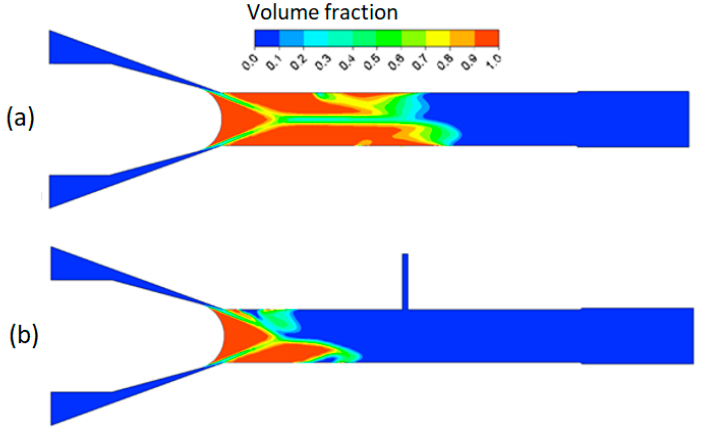
Figure 6. Vapor volume fraction ( a ) without secondary jet and ( b ) with secondary jet.